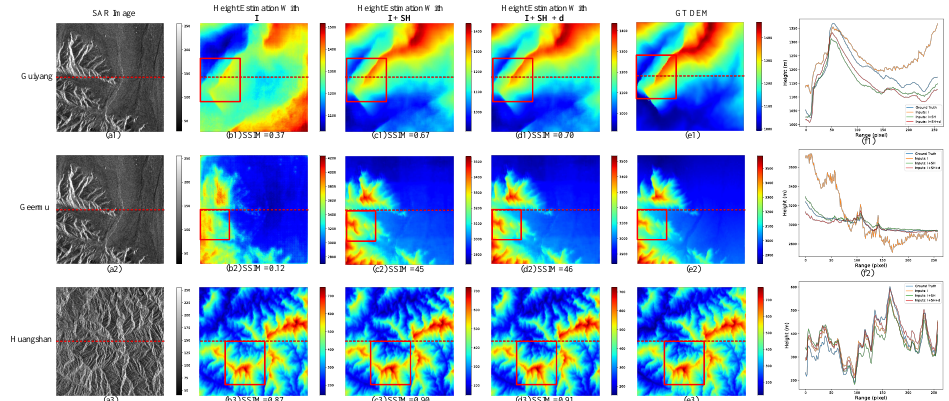
Figure 7. Local height estimation results from a single SAR based on SH , d and PDPNAS for Unet in Guiyang, Geermu and Huangshan datasets. The samples which measure 256 × 256 pixels are extracted from the whole test set. From left to right, there are ( a1 – a3 ) SAR images I , ( b1 – b3 ) estimated height maps with I as input, ( c1 – c3 ) estimated height maps with I and SH as inputs, ( d1 – d3 ) estimated height maps with I , SH and d as inputs. ( e1 – e3 ) are the ground truth height maps. Elevation lines along range directions with a fixed middle azimuth value marked by red dash lines in ( a1 – e1 ), ( a2 – e2 ), ( a3 – e3 ) are plotted in ( f1 – f3 ) respectively. The downsampling factors of SH are 96 ×